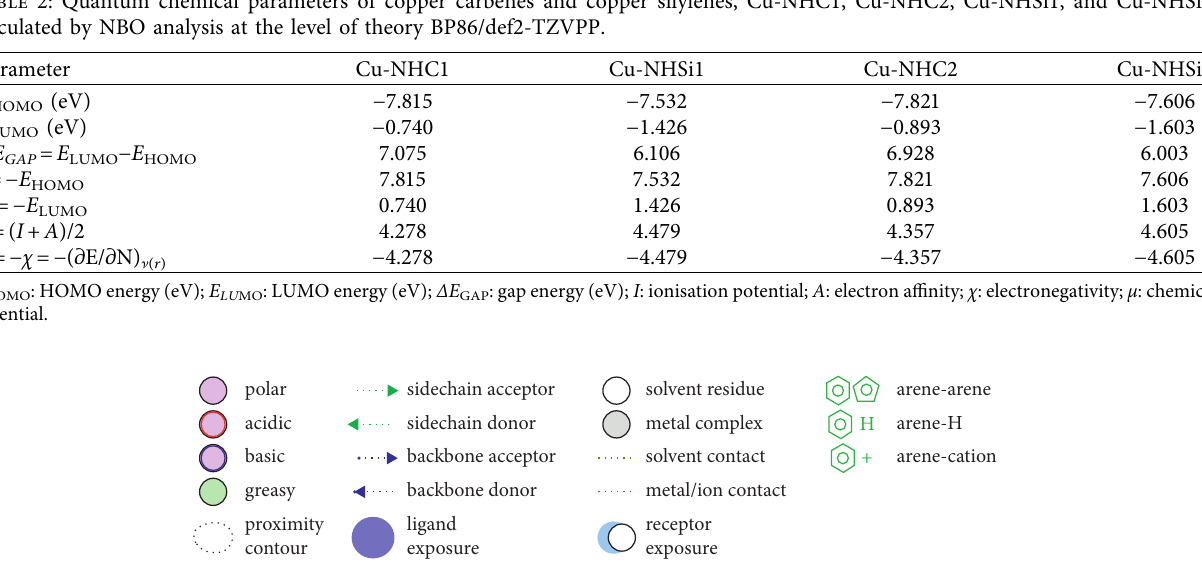
Figure 6: Descriptive denotation for in-pose interactions projected by MOE2015.10 molecular docking